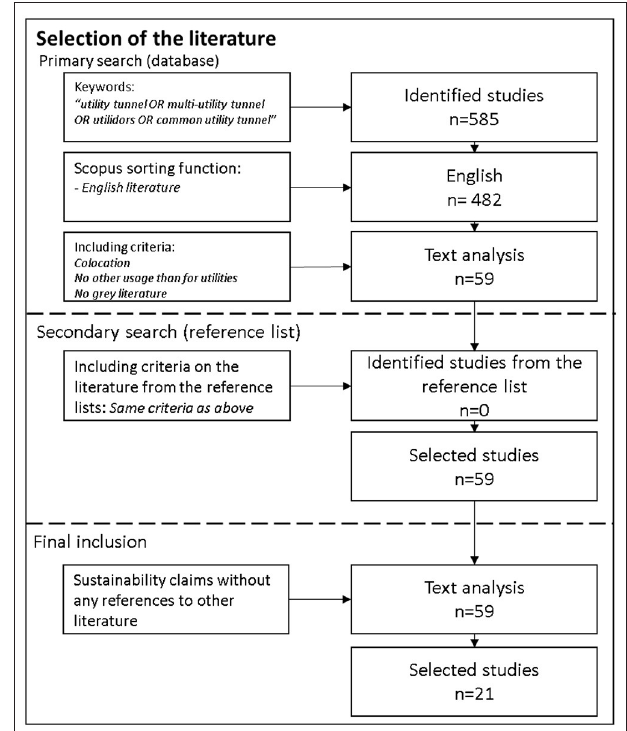
FIGURE 1 | Flow diagram describing the literature search and selection procedure. “n” is the number of articles selected in every